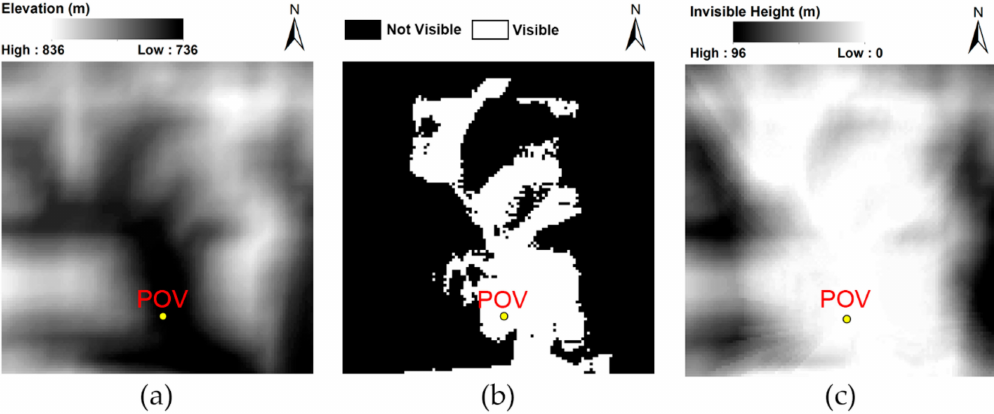
Figure 10. 3D viewshed analysis: ( a ) test digital elevation model (DEM) and POV which is 5 m above the ground; ( b ) 2D binary viewshed; ( c ) invisible height